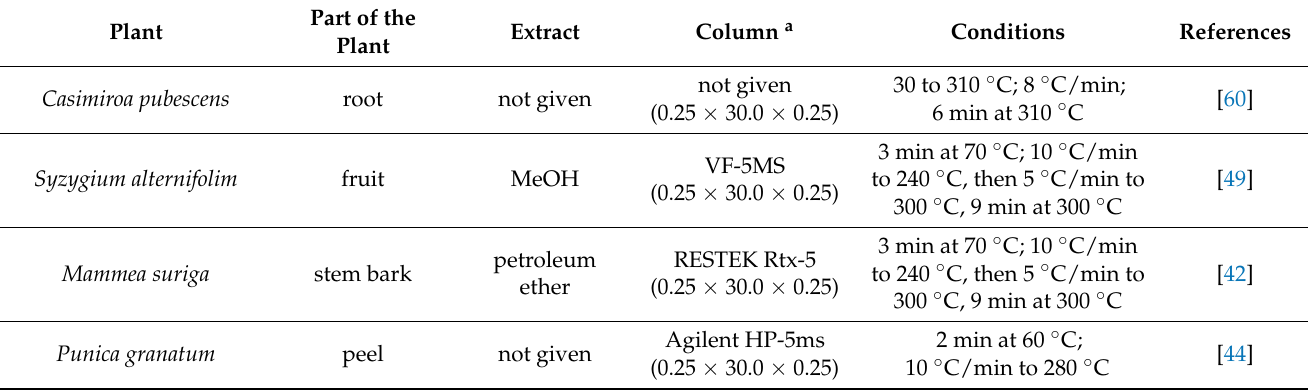
Table 4. Gas chromatography in the separation of zapotin.